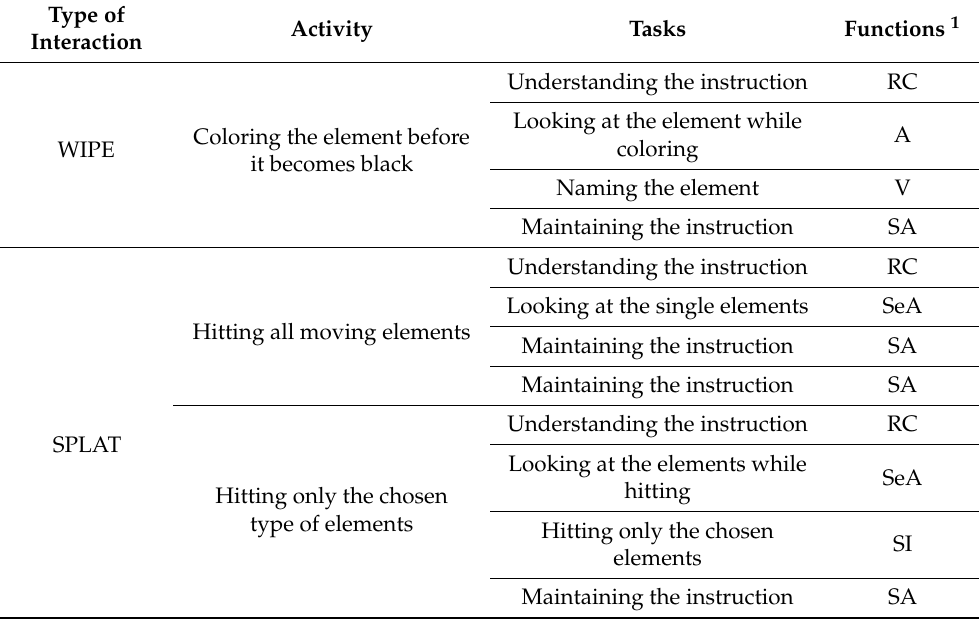
Table A2. Protocol used with the low-functioning